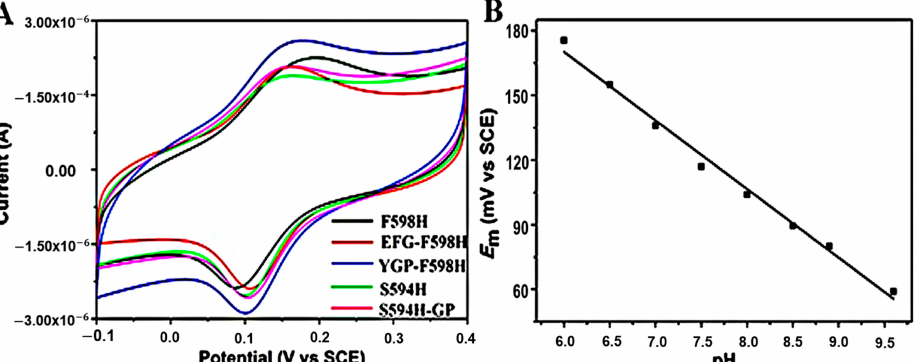
Figure 5. ( A ): Cyclic Voltammograms at MPA-modified Au electrode in 100 mM PBS (pH = 7.0) containing F598H (black), EFG-F598H (red), YGP-F598H (blue), S594H (green) and S594H-GP (pink). Potential scan rate: 100 mV/s; ( B ): Plots of the formal potentials of EFG-F598H as a representative at the MPA-modified Au electrode vs. solution